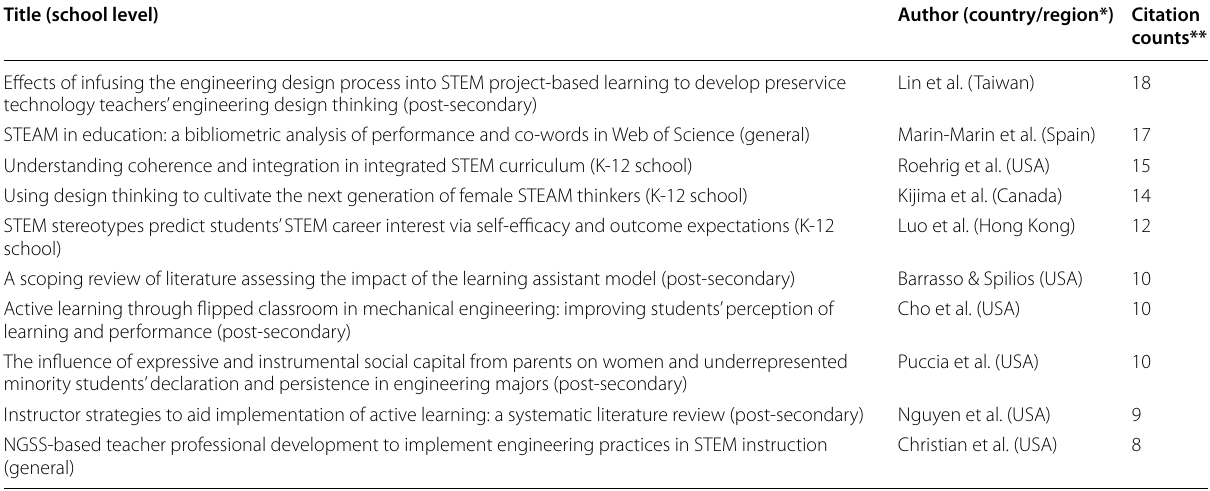
Table 4 Top 10 most-cited articles published in